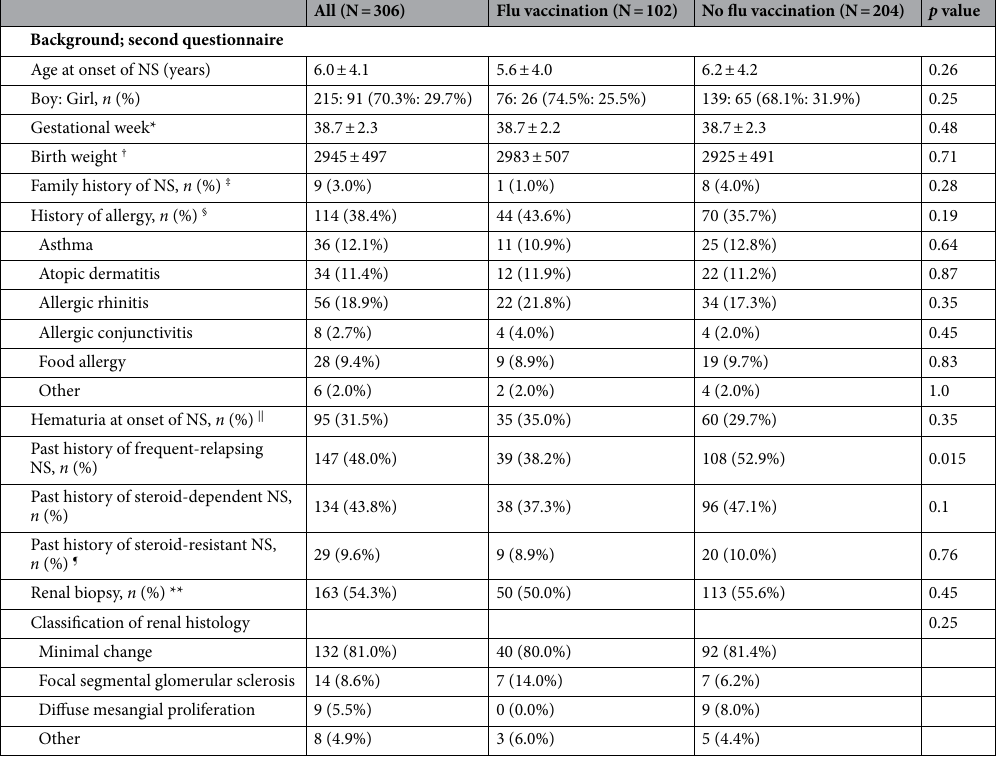
Table 1. Clinical characteristics of the patients. NS; nephrotic syndrome, Flu; influenza virus, FRNS; frequently relapsing NS, SDNS; steroid-dependent NS, SRNS; steroid-resistant NS. * Evaluated 246 children with data for gestational weeks. † Evaluated 254 children with data of birth weight. ‡ Evaluated 299 children with data for family history of SRNS. § Evaluated 297 children with data for history of allergy. || Evaluated 302 children with data for hematuria at onset of NS. ¶ Evaluated 301 children with data of past history of SRNS. ** Evaluated 300 children with data of renal biopsy.